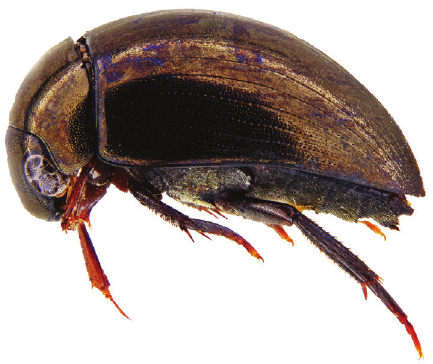
Figure 16. Regimbartia nilotica (Sharp, 1903) 5.4 mm, iSimangaliso Wetland Park, False Bay (site 27), January 2015 DT Bilton, MS Bird & R Perissinotto leg.